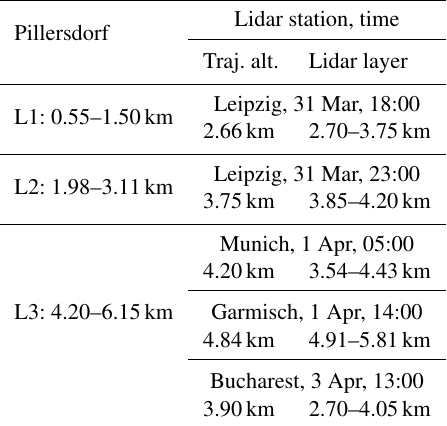
the methodology described in Sect. 2. The layers identified are marked on the corresponding RCS plot.